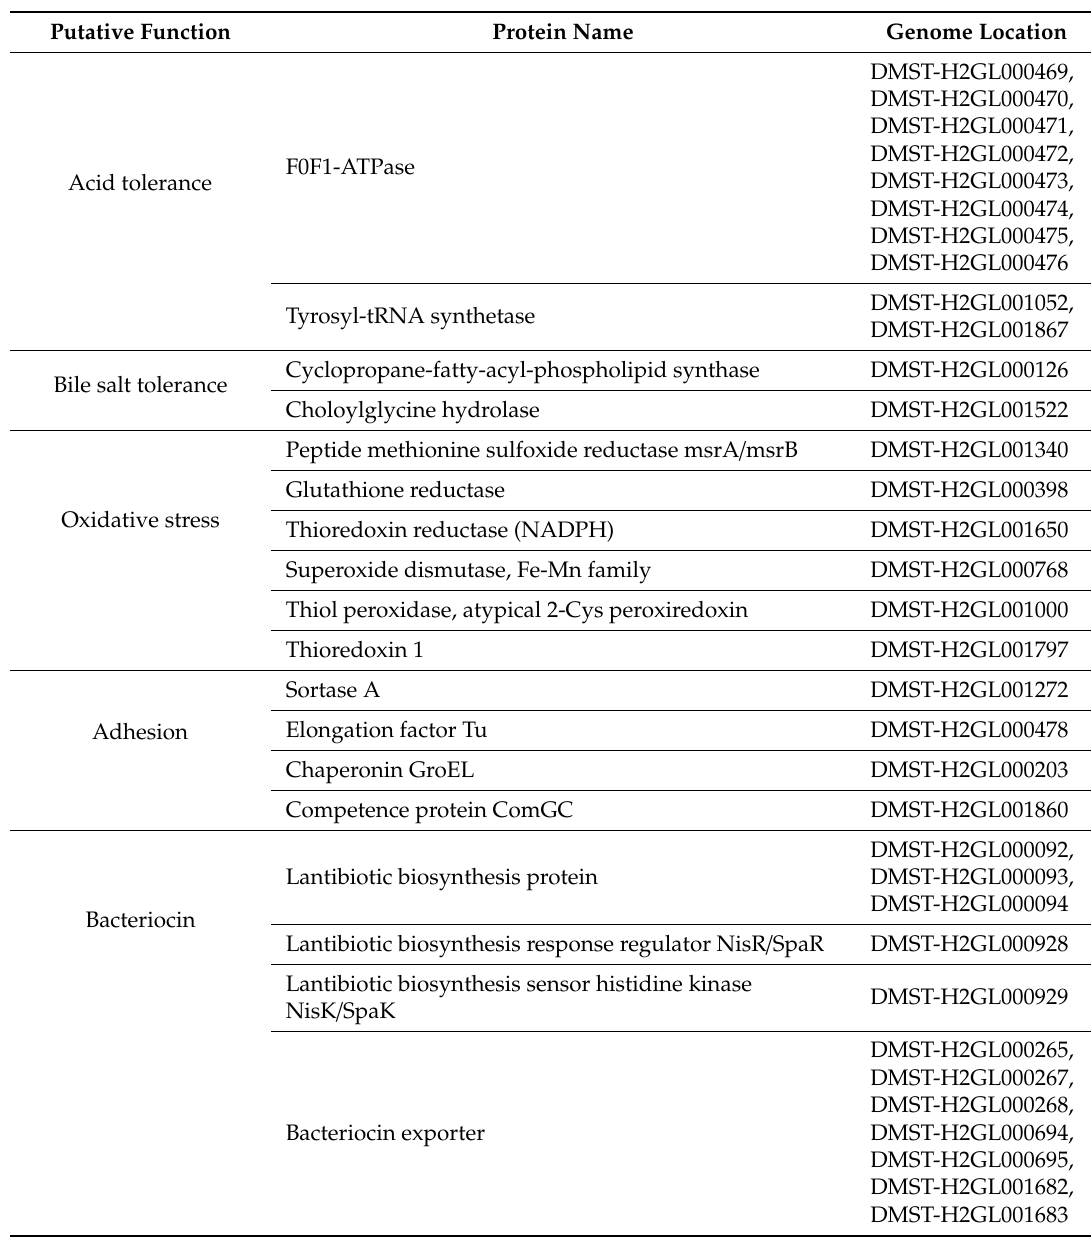
Table 2. Putative genes for probiotic properties in